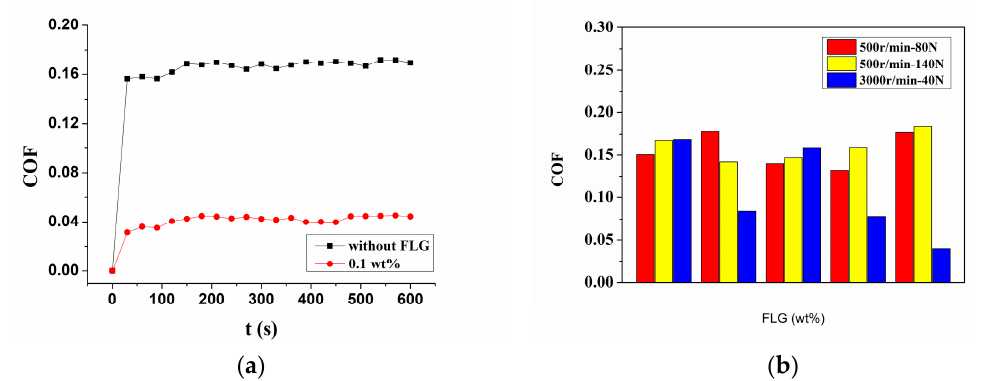
Figure 2. Friction coefficient (COF) results for Si 3 N 4 /Si 3 N 4 sliding pairs under three working conditions. ( a ) COF with a 40 N load and 3000 r·min − 1 rotating speed with and without 0.1 wt% FLG; ( b ) comparison of COF results under three different working conditions.